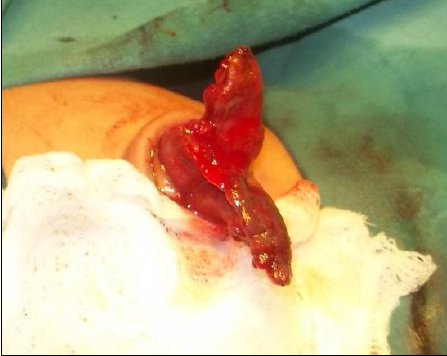
Figure 1: Bowel loops after removing sac of hernia of umbilical cord.